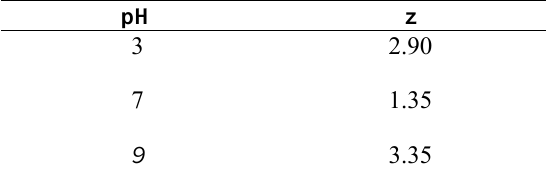
Table 1 Consumed mole of ozone per mole of each